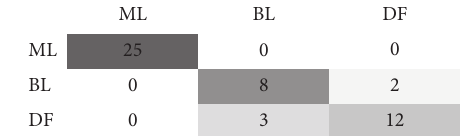
Figure 7: Confusion matrix for the results of state recognition (ML, mixed lubrication; BL, boundary lubrication; DF, dry